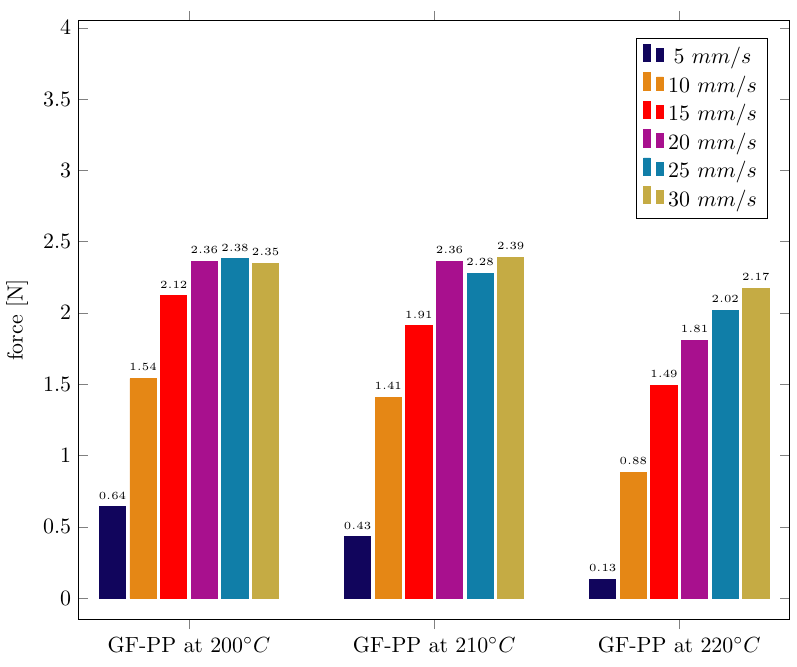
Figure 11. Comparison of the mean values in the steady state process condition.